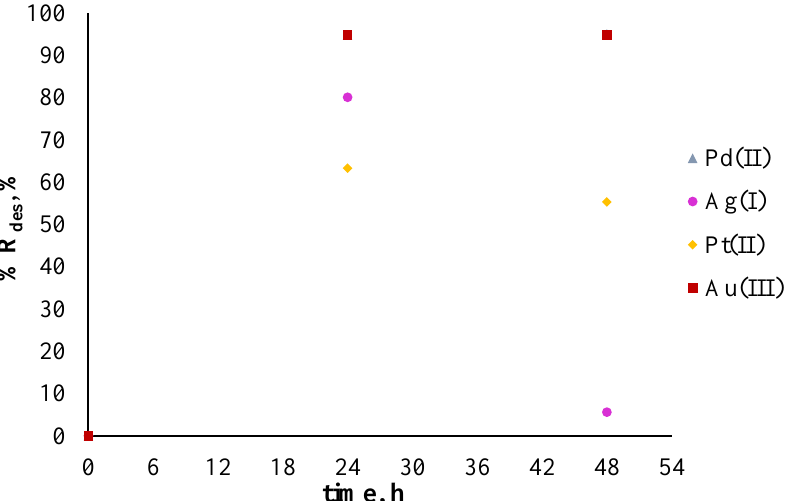
Figure 10. The sum of desorbed metal ions after 24 and 48 h from the surface of membranes previously used to absorb metal ions from a polymetallic solution. The given values of %R des carry ± 0.01. The highest percentage recovery was observed after 24 h of desorption for Pd(II)